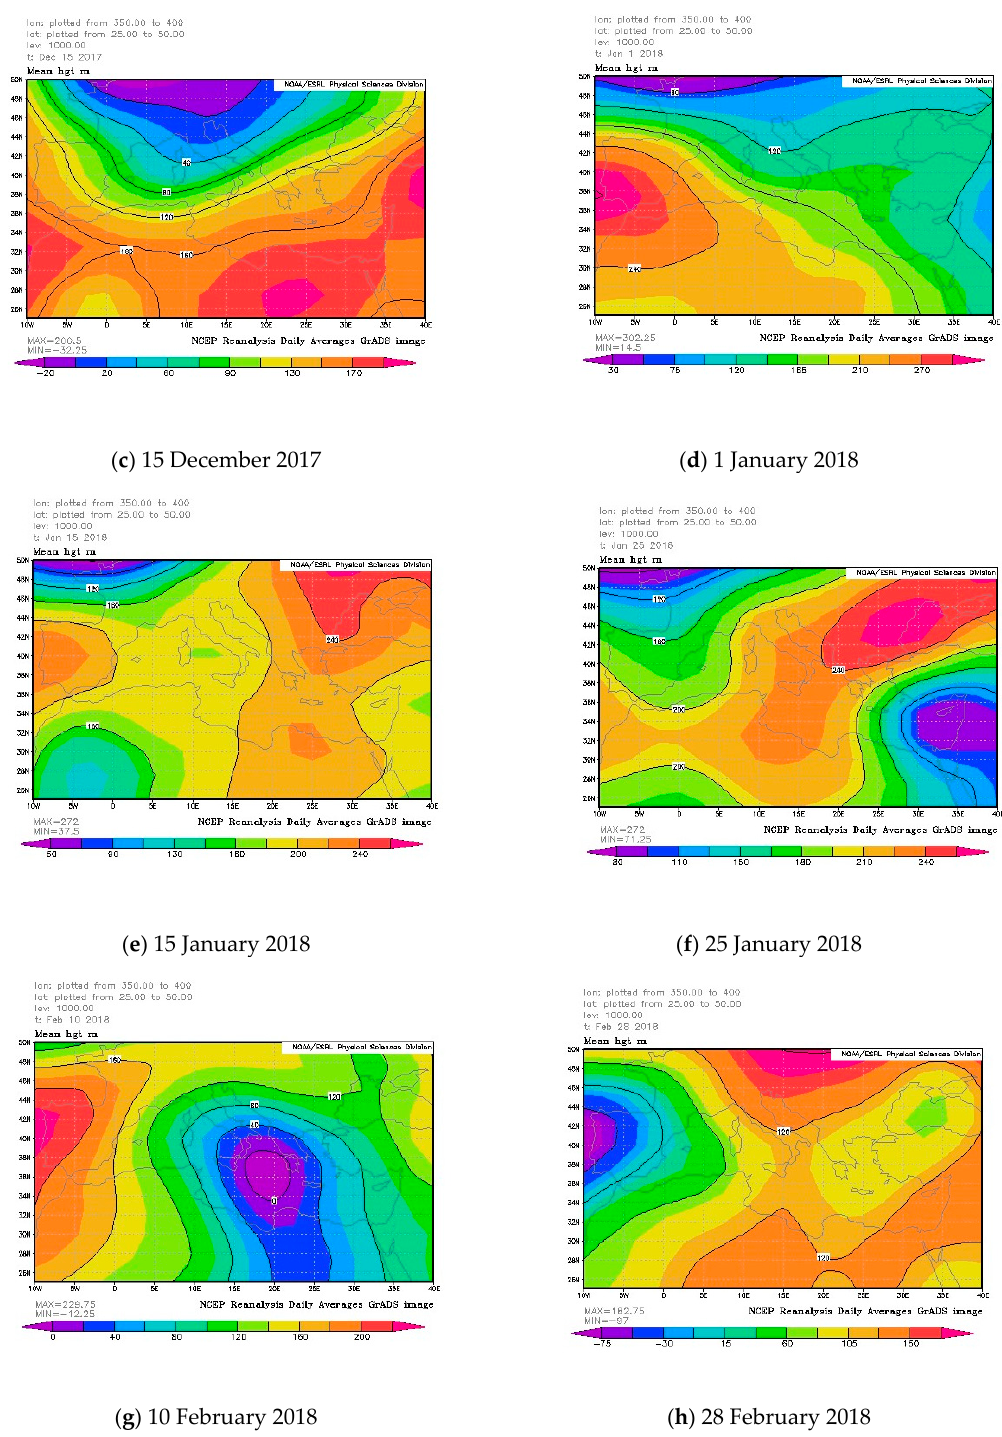
Figure 3. Same as Figure 2 but for geopotential heights [gpm].